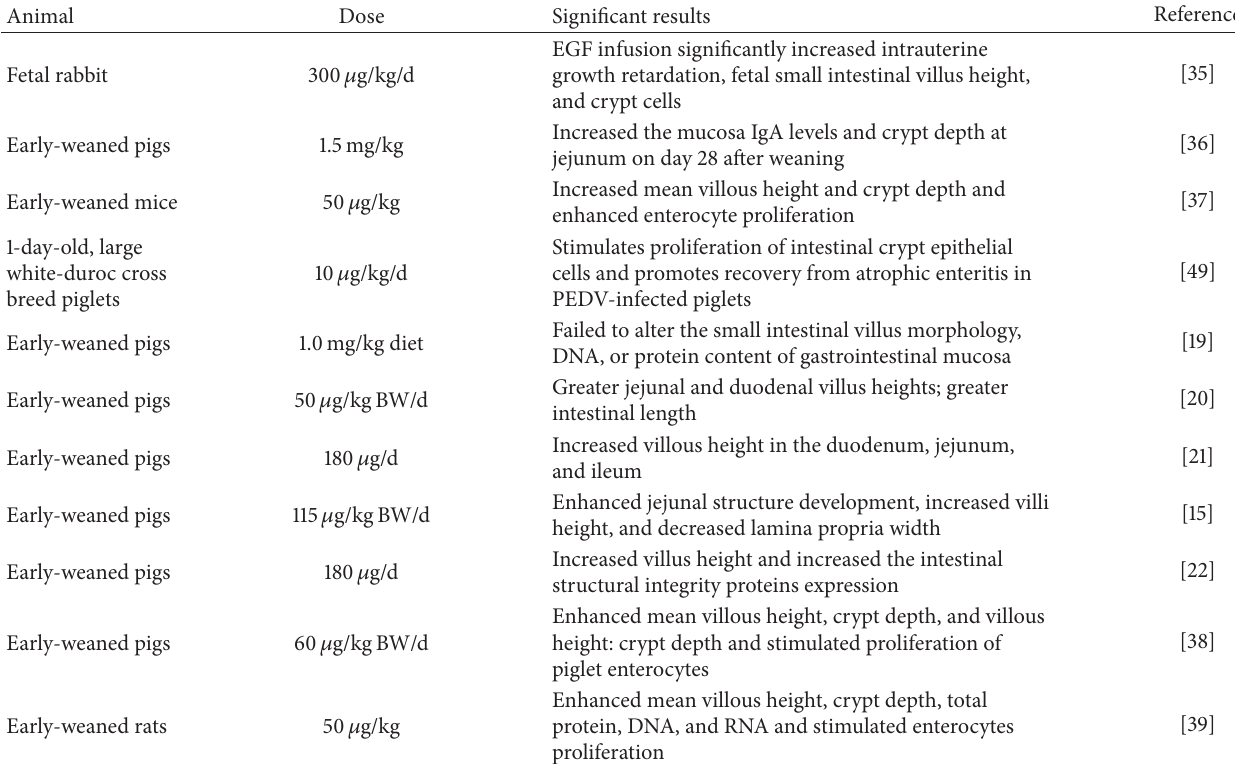
Table 1: The applications of EGF for animals on intestinal